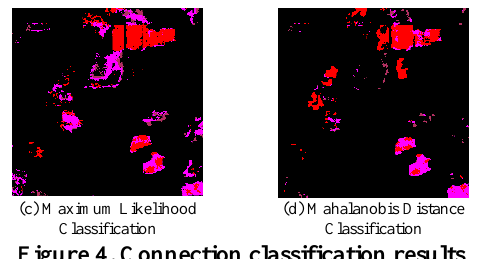
Figure 4. Connection classification results in the downtown area